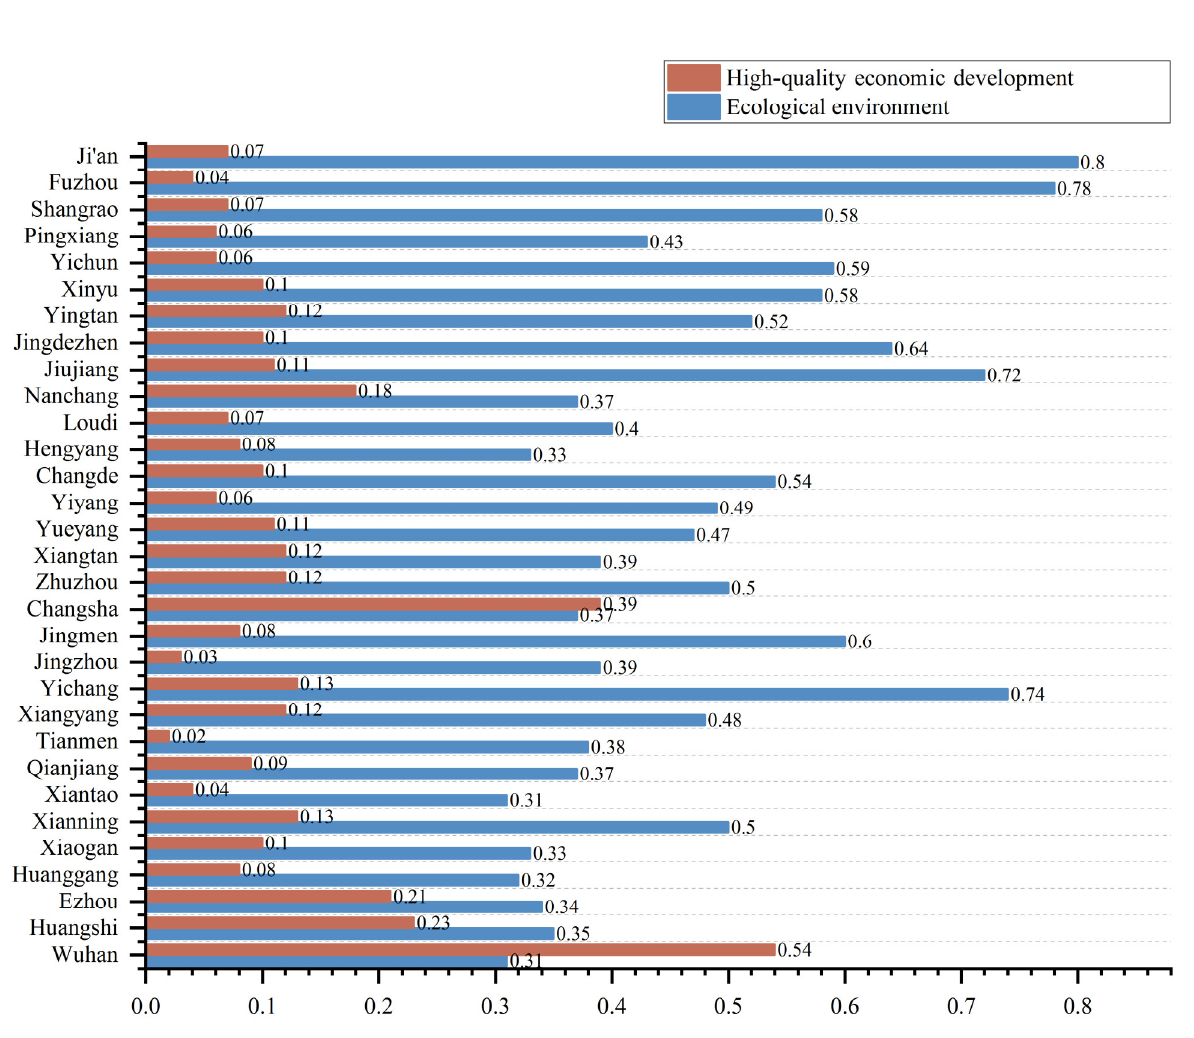
Figure 4. Comprehensive evaluation index of 31 cities’ EE and